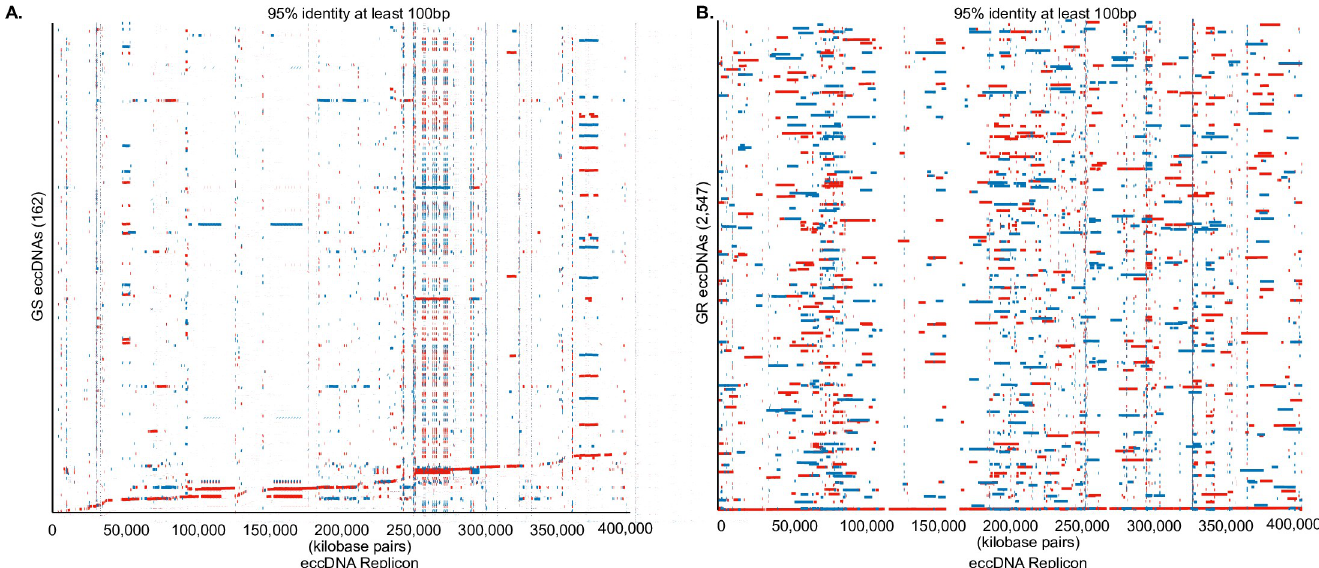
Fig 5. Alignment of eccDNA to the replicon in GS and GR biotypes. A. Alignment of 162 GS eccDNA to the eccDNA replicon. B. Alignment of 2,547 GR eccDNA to the eccDNA replicon. Red colors indicate indirect orientation and blue are direct. Alignments are filtered for matches of at least 95% identity and matches of at least 100 bp.